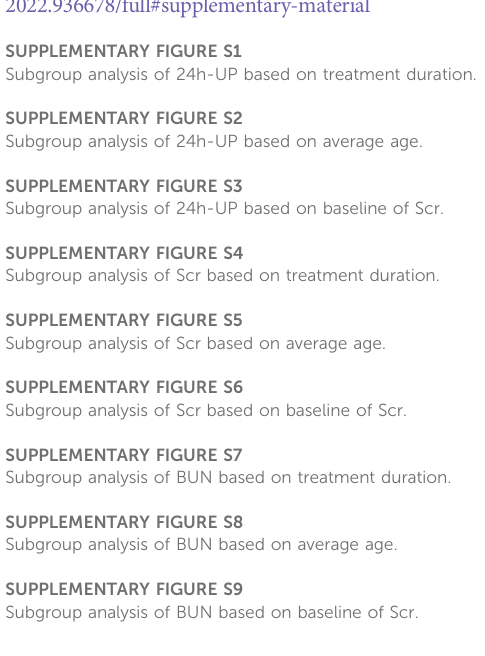
SUPPLEMENTARY FIGURE S1 Subgroup analysis of 24h-UP based on treatment duration. SUPPLEMENTARY FIGURE S2 Subgroup analysis of 24h-UP based on average age. SUPPLEMENTARY FIGURE S3 Subgroup analysis of 24h-UP based on baseline of Scr. SUPPLEMENTARY FIGURE S4 Subgroup analysis of Scr based on treatment duration. SUPPLEMENTARY FIGURE S5 Subgroup analysis of Scr based on average age. SUPPLEMENTARY FIGURE S6 Subgroup analysis of Scr based on baseline of Scr. SUPPLEMENTARY FIGURE S7 Subgroup analysis of BUN based on treatment duration. SUPPLEMENTARY FIGURE S8 Subgroup analysis of BUN based on average age. SUPPLEMENTARY FIGURE S9 Subgroup analysis of BUN based on baseline of